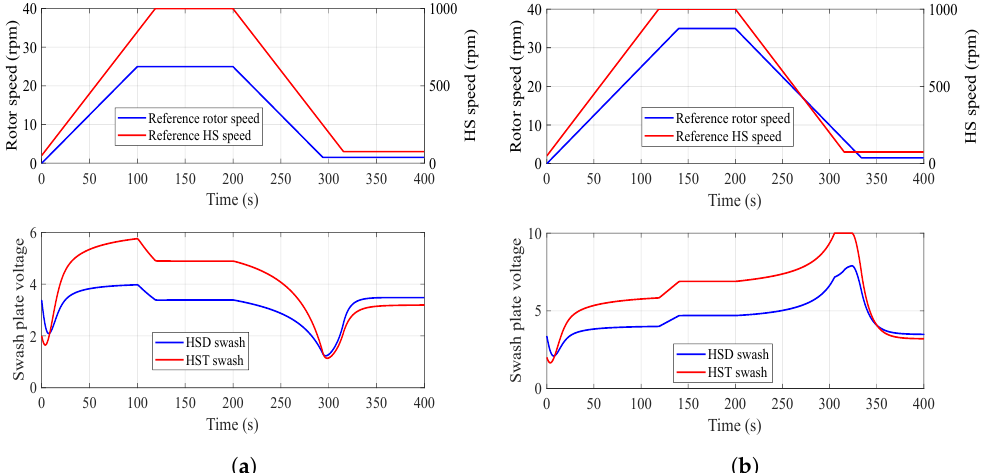
Figure 14. Simulation of start and stop phase for ω st = 1000 rpm with a constant slope. ( a ) HSD and HST input for ω rt = 25 rpm. ( b ) HSD and HST input for ω rt = 35